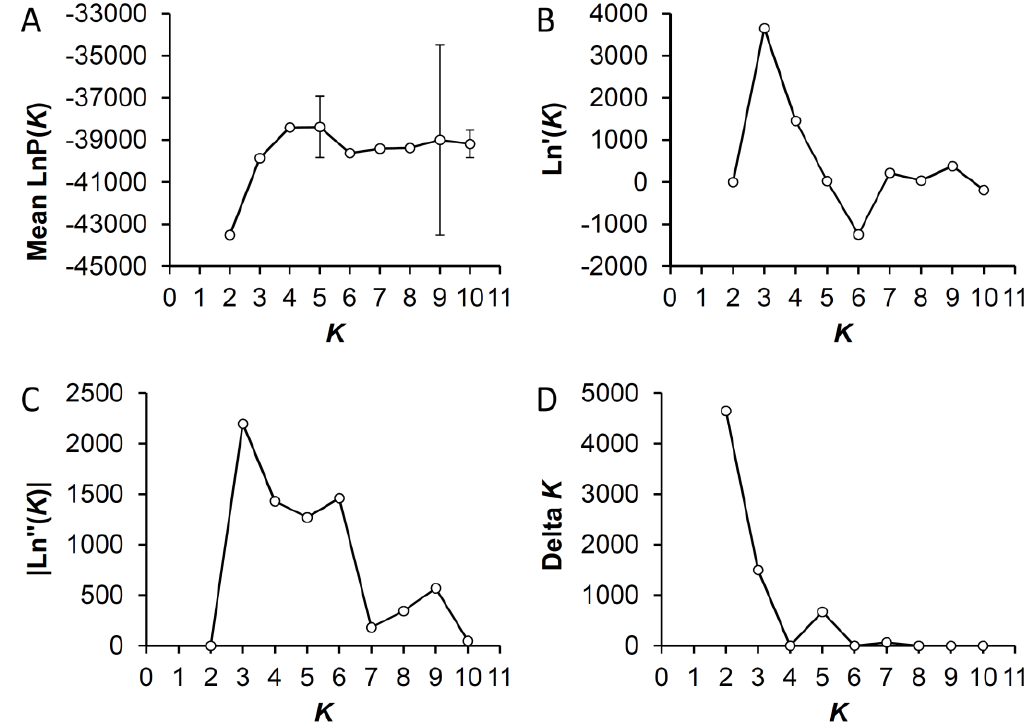
P( K ); ( B ) L '( K ), equation to n n